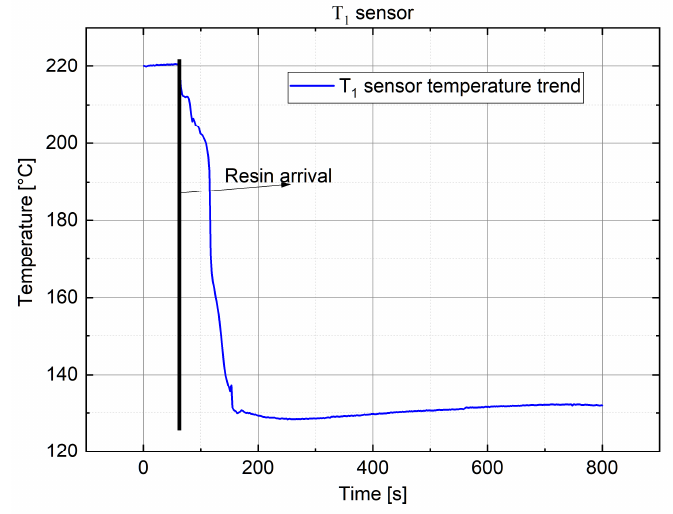
Figure 14. Temperature variation measured with FBG sensor T1.